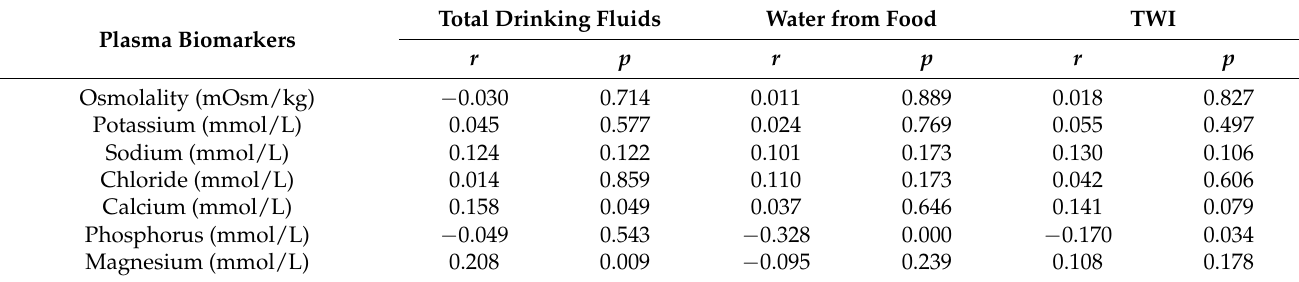
Table 2. Correlations between the fluid intake and plasma biomarkers of young